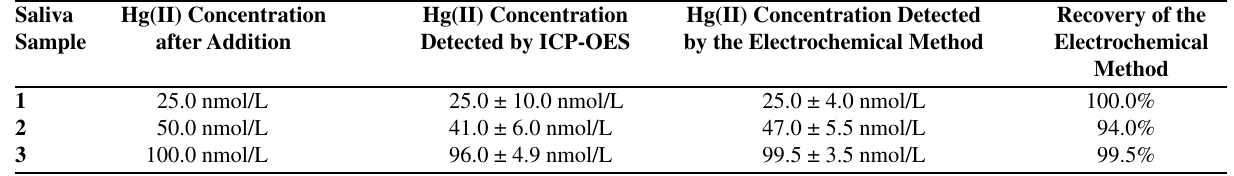
Table 2: Concentrations of Hg(II) in spiked saliva samples measured by PGPE and inductively coupled plasma (ICP-OES). Saliva Hg(II)